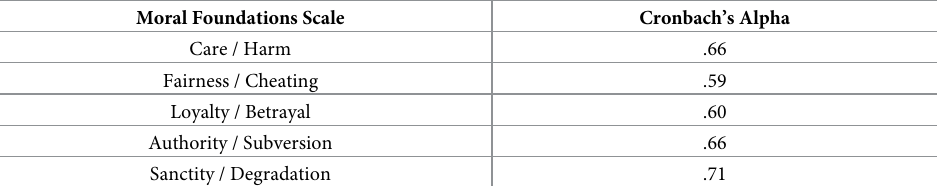
Table 1. Cronbach’s Alpha levels for the moral foundations